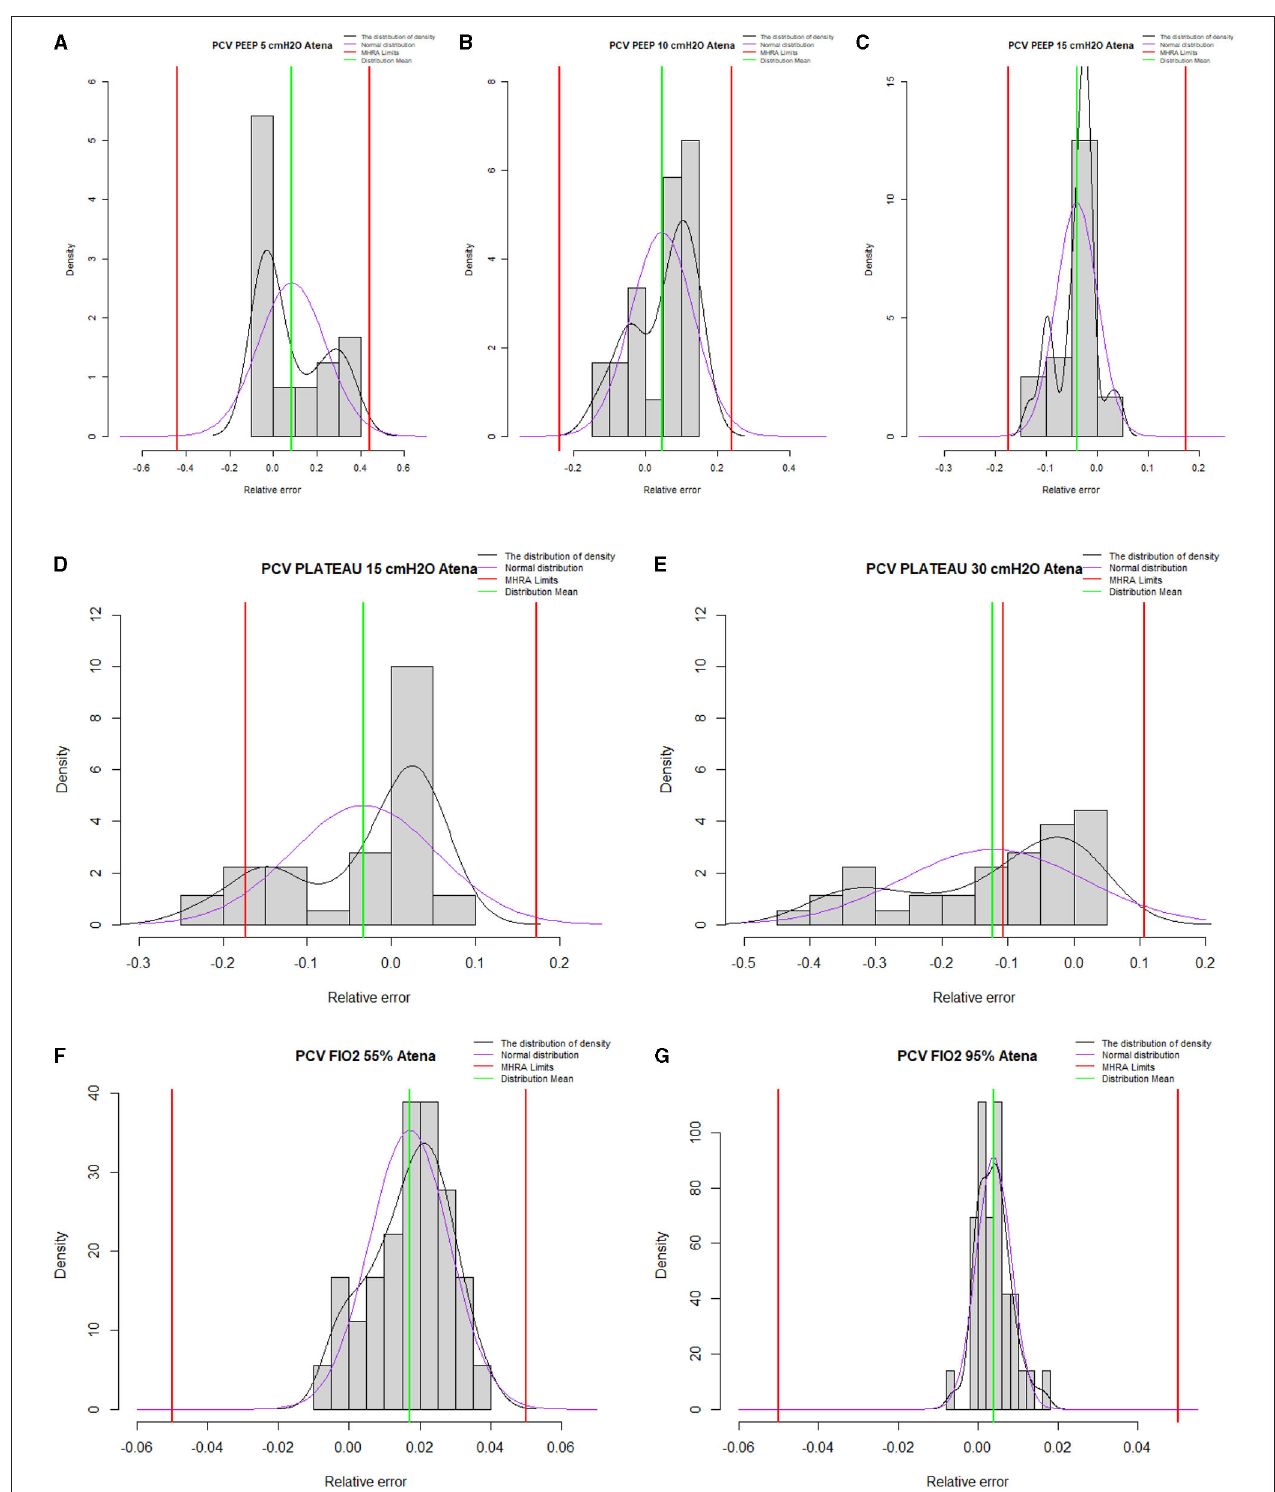
FIGURE 5 | Summary histograms for all pressure-controlled ventilation test conditions. (A–C) represent histograms for PEEP 5, 10, and 15 cmH 2 O, respectively. (D,E) represent histograms for plateau pressure of 15 and 30 cmH 2 O, respectively. (F,G) represent histograms for 55 and 95% of FiO 2 . Outside the red limits data points